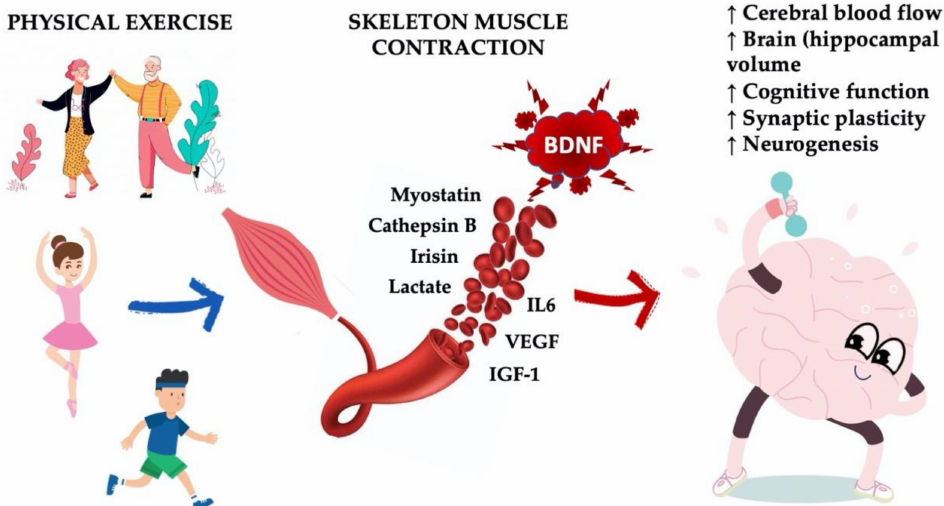
Figure 1. Proposed mechanism for the impact of physical activity on brain functions. The central nervous system (CNS) and peripheral skeletal muscle interconnection initiate movement, which results in skeletal muscle contractions and neuronal activation. Repeated physical activity triggers neurotrophic growth factors (e.g., brain-derived neurotrophic factor (BDNF), vascular endothelial growth factor (VEGF), insulin-like growth factor 1 (IGF-1), as well as myokine (e.g., irisin, cathepsin B) release; it also promotes neurogenesis, synaptic plasticity, and the improvement of cognitive